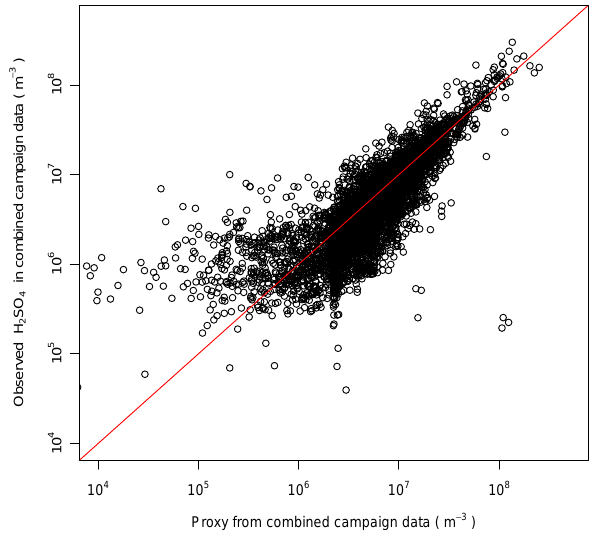
Fig. 6. Observed [H 2 SO 4 ] in combined campaign data vs. predicted values given by Proxy N5. Diagonal line represents the perfect